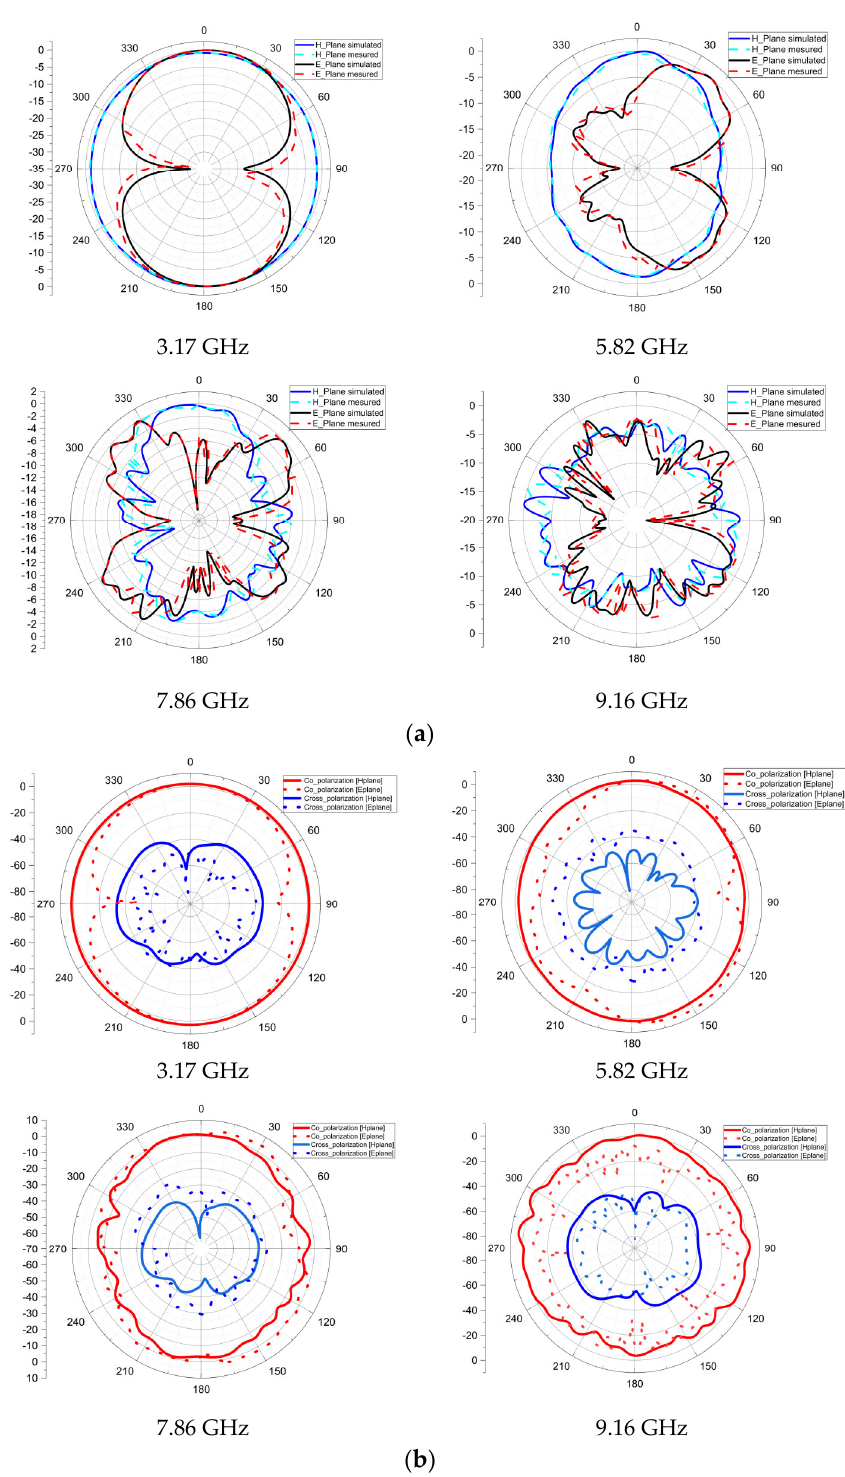
Figure 12. ( a ) 2D radiation pattern and ( b ) Co-polarization and cross-polarization. Group delay and time domain characteristics are two different measures of an an- tenna’s performance in the time domain.